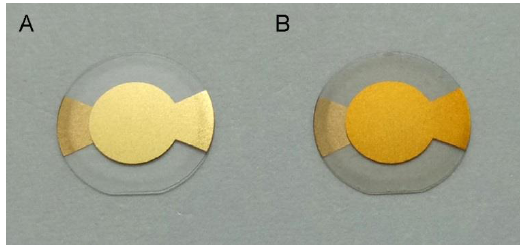
Figure 3. The QCM gold sensor chip before ( A ) and after ( B ) PDA (polydopamine) coating.